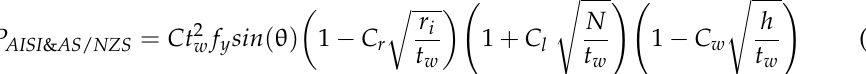
Figure 2. Four loading cases for web crippling tests